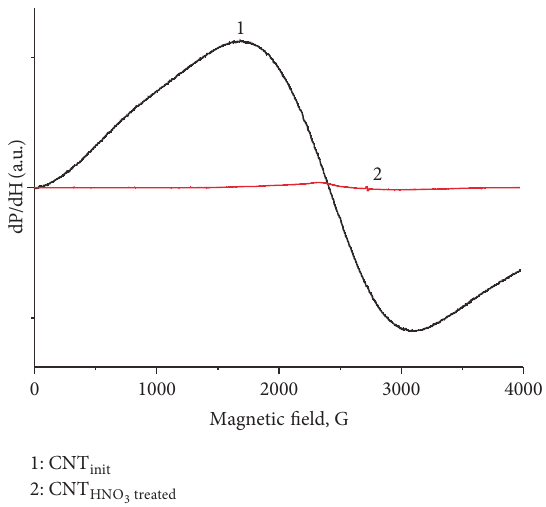
Figure 3: ESR spectra of as-prepared ( 1 ) and treated with nitric acid (2) carbon nanotubes